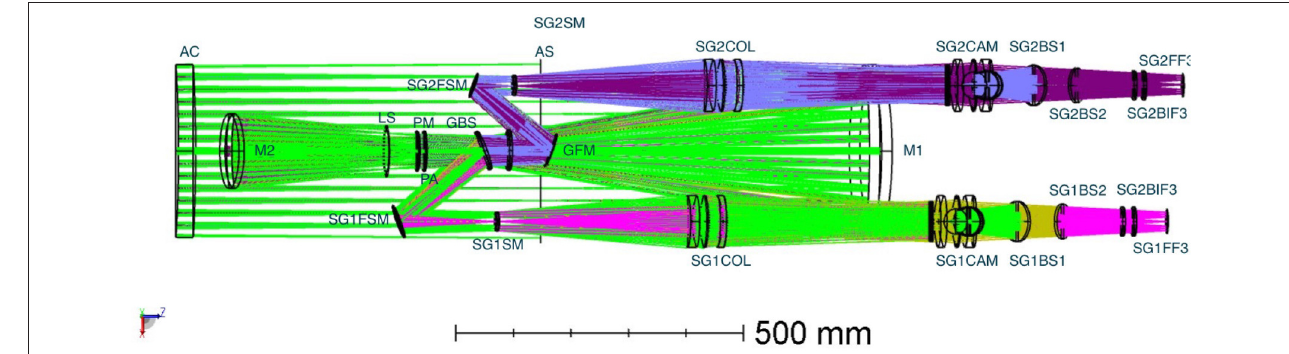
FIGURE 5 | ZEMAX Top view of mxCSM.